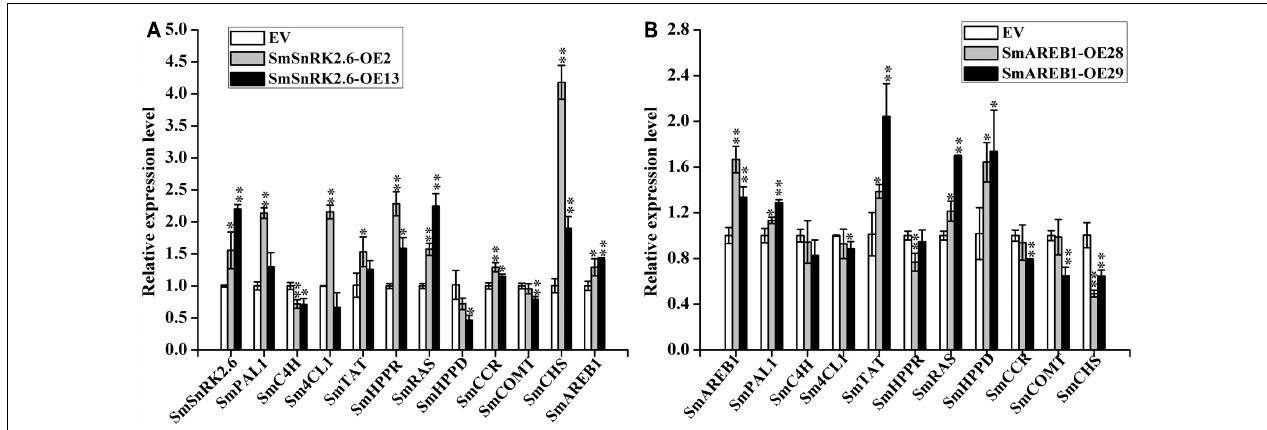
FIGURE 8 | Quantitative real-time PCR analysis of related genes in EV, SmSnRK2.6-overexpressing transgenic lines ( SmSnRK2.6-OE2 and SmSnRK2.6-OE13 ) (A) , and SmAREB1-overexpressing transgenic lines ( SmAREB1-OE28 and SmAREB1-OE29 ) (B) . PAL, phenylalanine ammonia lyase; C4H, cinnamic acid 4-hydroxylase; 4CL, 4-coumaric acid CoA-ligase 1; TAT, tyrosine aminotransferase; HPPR, 4-hydroxyphenylpyruvate reductase; RAS, rosmarinic acid synthase; HPPD, 4-hydroxyphenylpyruvate dioxygenase; CHS, chalcone synthase; CCR, cinnamoyl-CoA reductase; COMT, caffeic acid O -methyltransferase. Data represent means ± SD of three replicates. Asterisks denote significant differences at ∗ P < 0.05, ∗∗ P < 0.01, compared to the vector control and obtained via Student’s t